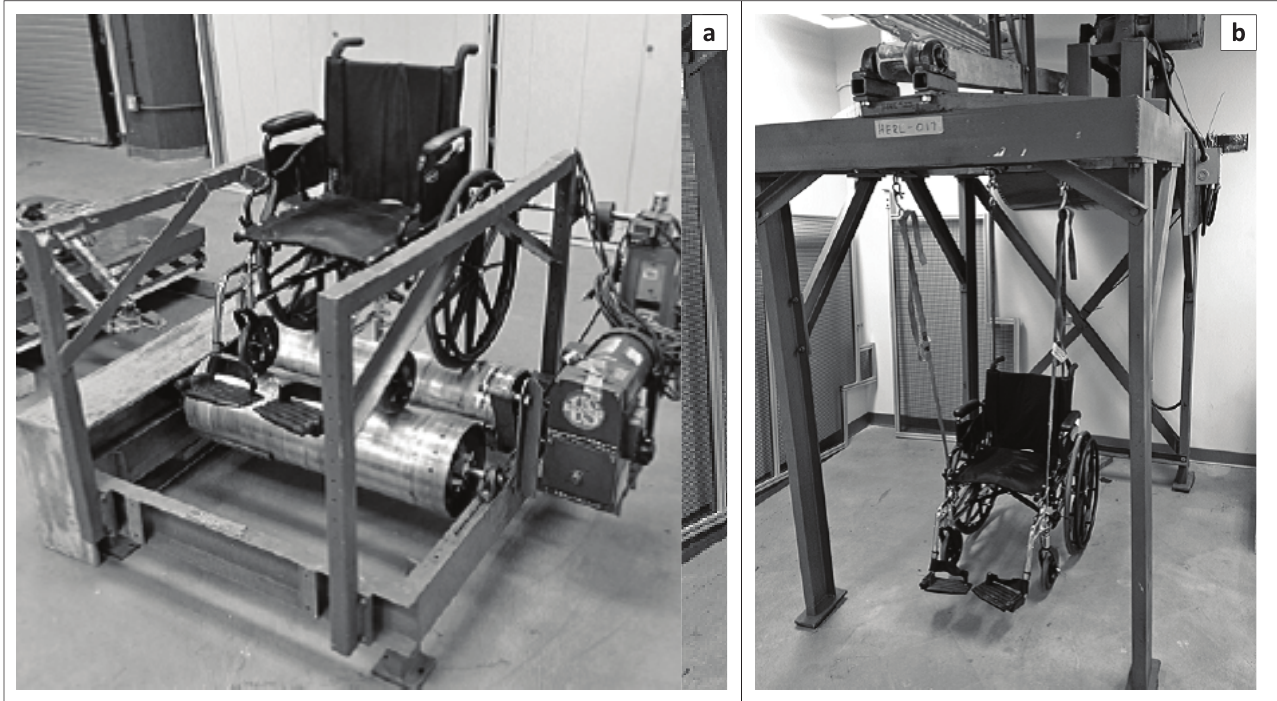
FIGURE 3: Multi-drum test (left) and curb-drop test (right) without test